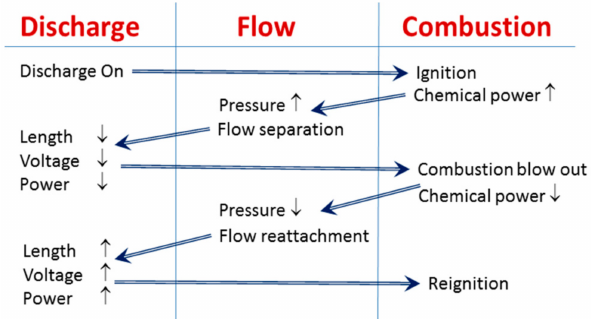
Figure 29. Diagram illustrating a feedback loop of combustion instability development. Small vertical arrows show an increase (up) or reduction (down) of parameter values. Larger inclined arrows show the sequence of processes involved.